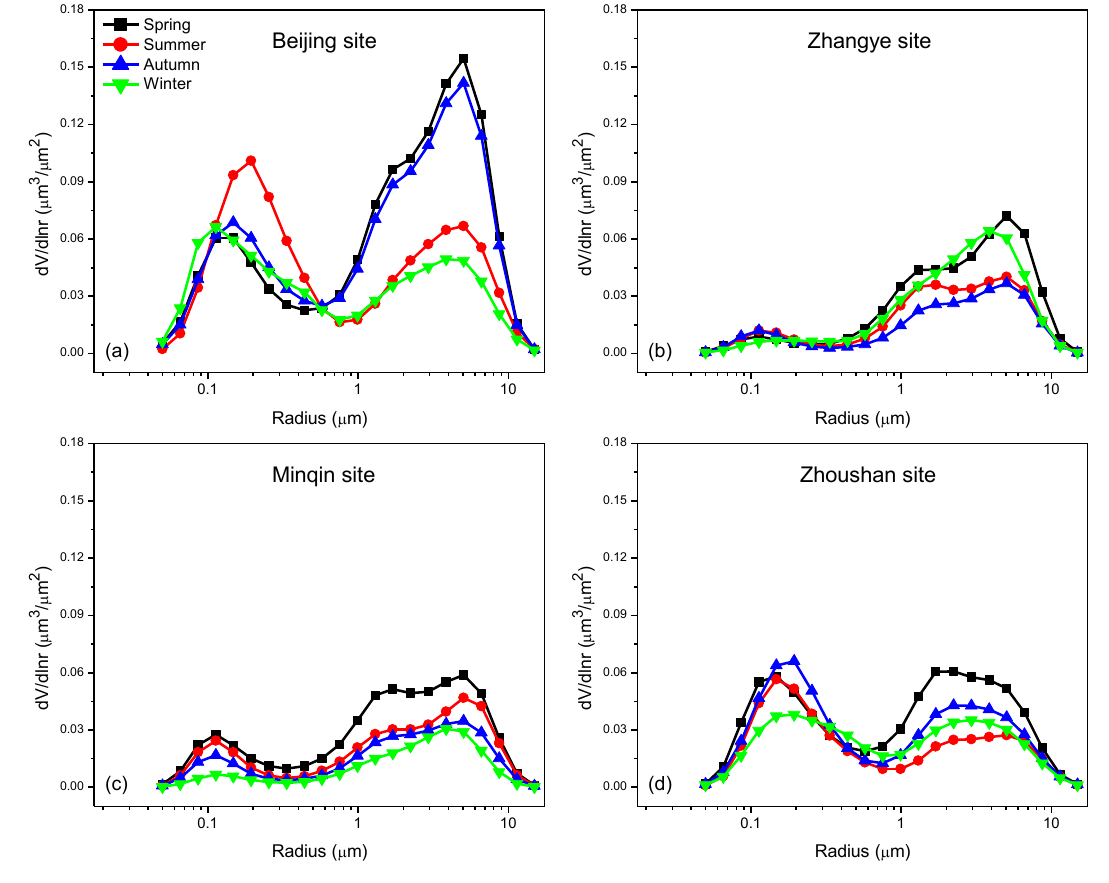
Figure 4. Seasonal average of volume size distributions of the four sites. ( a ) Beijing site; ( b ) Zhangye site; ( c ) Minqin site; ( d ) Zhoushan